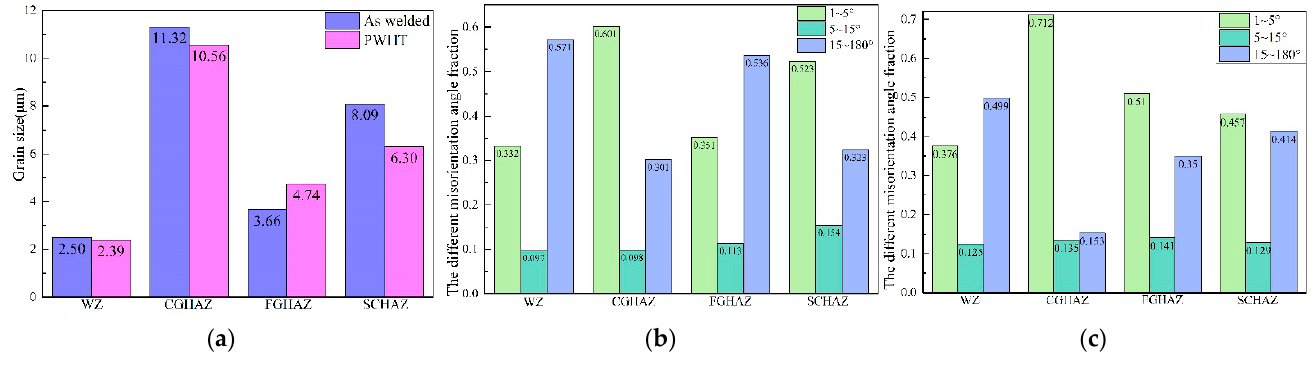
Figure 5. ( a ) Grain size following PWHT; ( b ) the grain-orientation angle of the welded joint; and ( c ) the grain-orientation angle after PWHT.